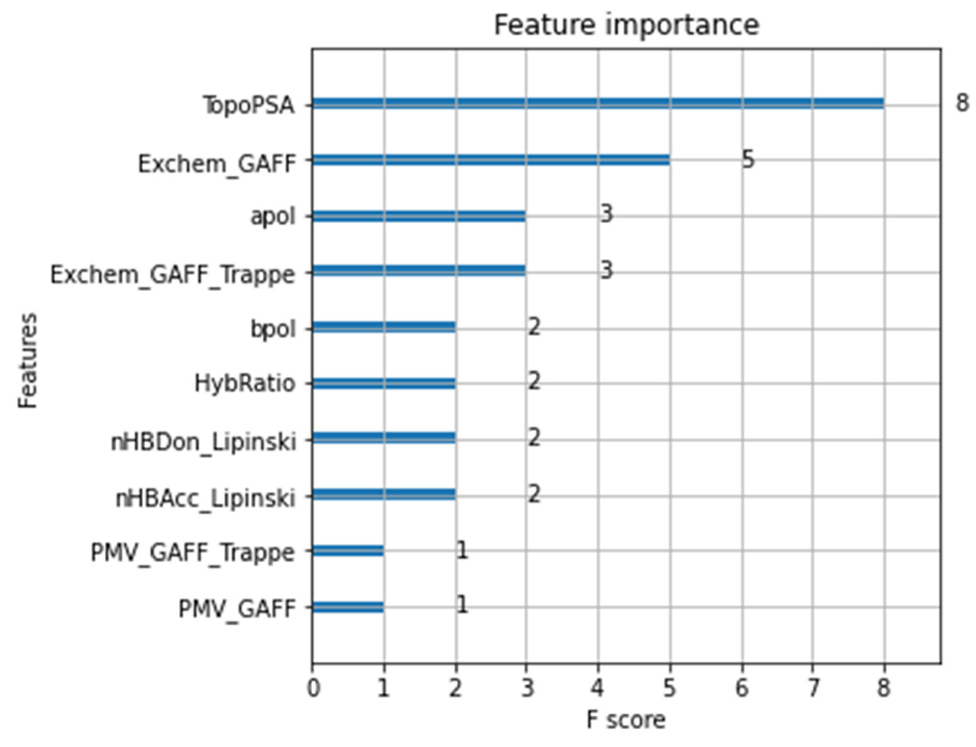
Figure 3. Feature importance for the quantitative partitioning calculations using the XGBoost method.